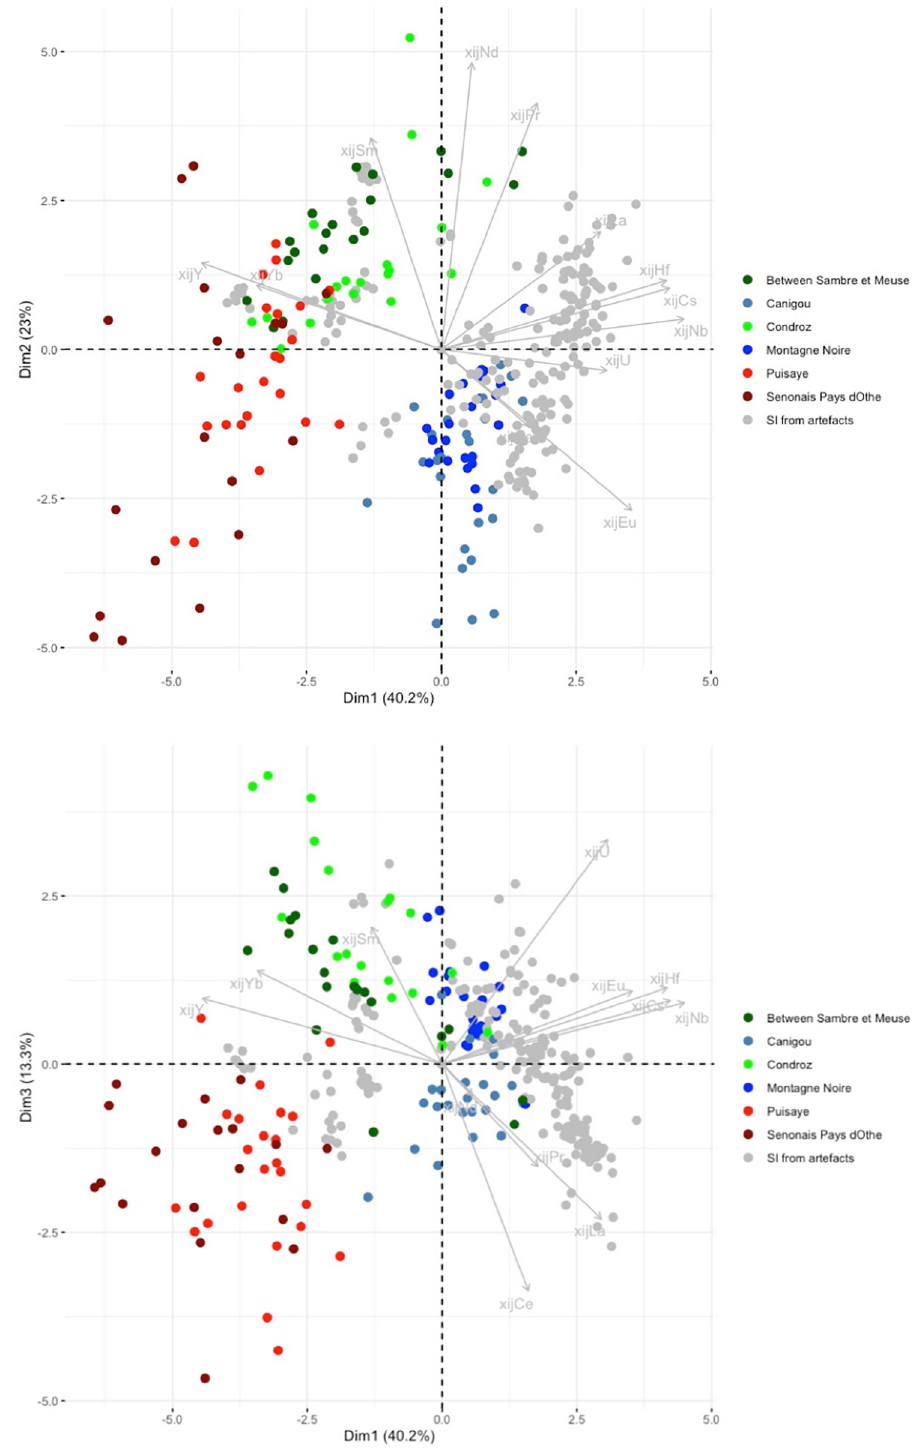
Fig 13. PCA on xij of production area slag. Only slag from production areas are highlighted. SI from artefacts are presented in grey. % between brackets: % of total variance.